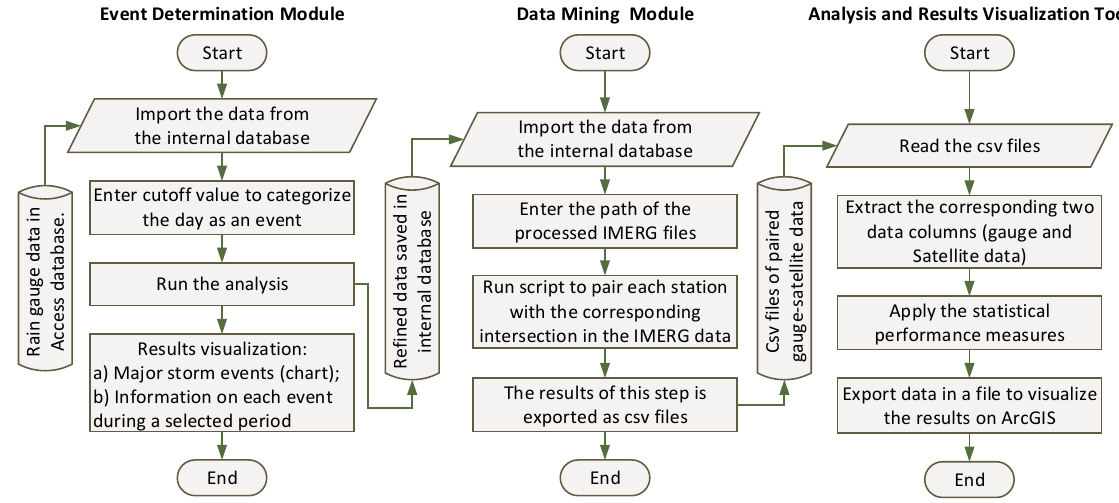
Figure 2. Schematic diagram of the event determination, matching coordinates, and data analysis modules.